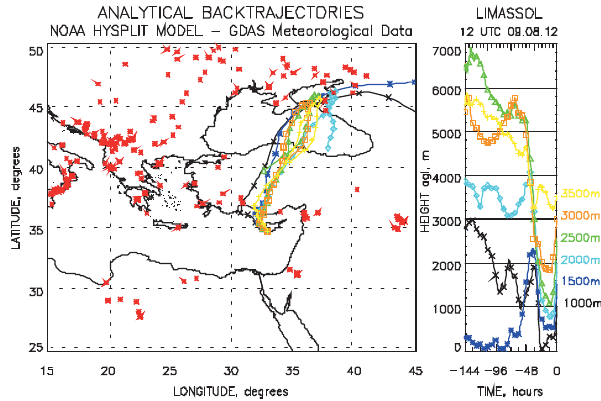
Figure 2. 532nm particle backscatter coefficient (left, green) and particle linear depolarization ratio (right, black) in the free tro- posphere during northerly airflow. No fires occurred over Turkey (smoke-free case). The grey-shaded area indicates the identified lofted aerosol layer. AE A , AOT A , and FMF A in the left panel de- note Ångström exponent, aerosol particle optical thickness, and fine-mode fraction derived from AERONET photometer observa- tions (for the total tropospheric column). Retrieved lidar ratios S FT for the free troposphere and S COL for the total column obtained af- ter Mamouri et al. (2013) are given in the right panel. The boundary- layer lidar ratio S PBL (for the lowest 400m) is required as input in this retrieval. In addition, the mean particle depolarization ratio δ FT for the grey-shaded lofted aerosol layer is given together with the standard deviation.